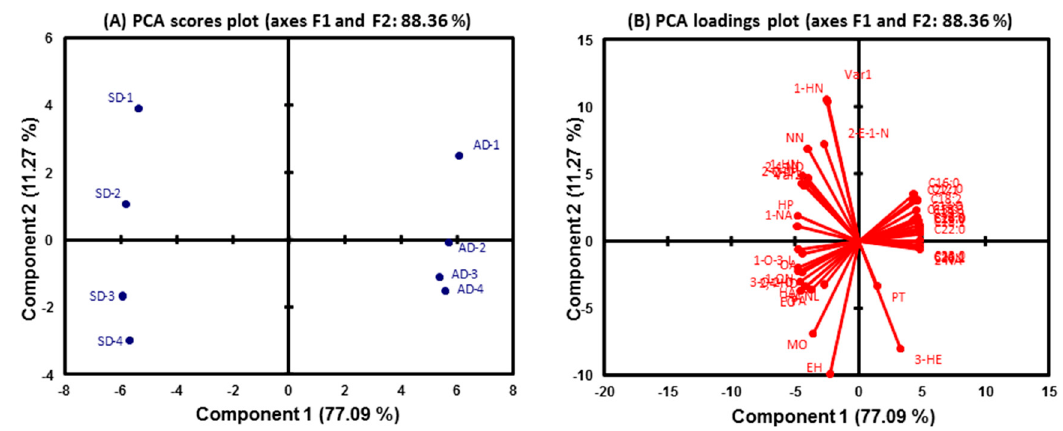
Figure 5. PCA ( A ) score plot for samples and ( B ) loadings plot based on fatty acids and their derived volatile compounds during storage.